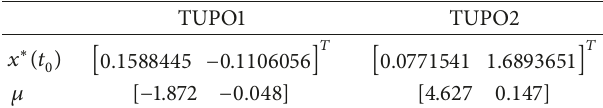
Table 1: Floquet multipliers and one Poincar´e map point for 𝑎 = 0.988 of the two target periodic orbits of the vdP oscillator.